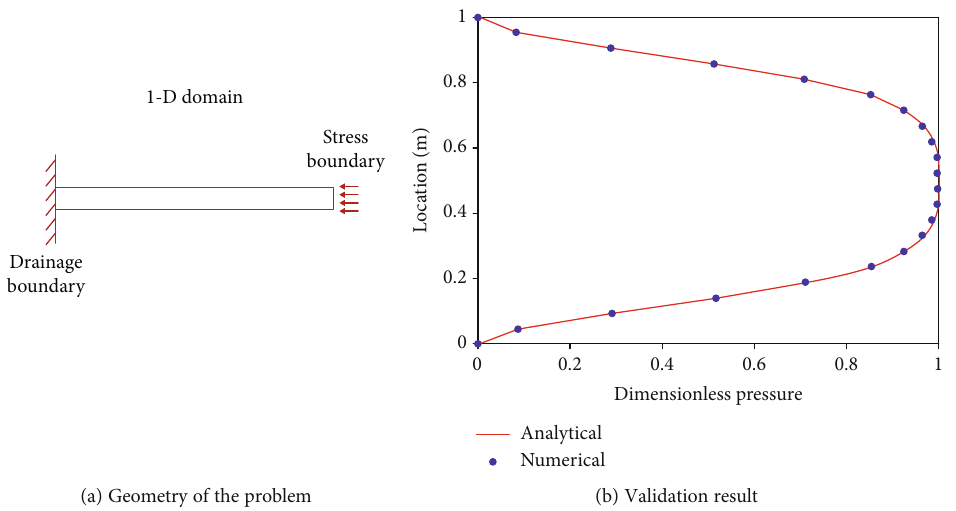
Figure 1: Validation with Terzaghi ’ s problem. Table 1: Parameters for model